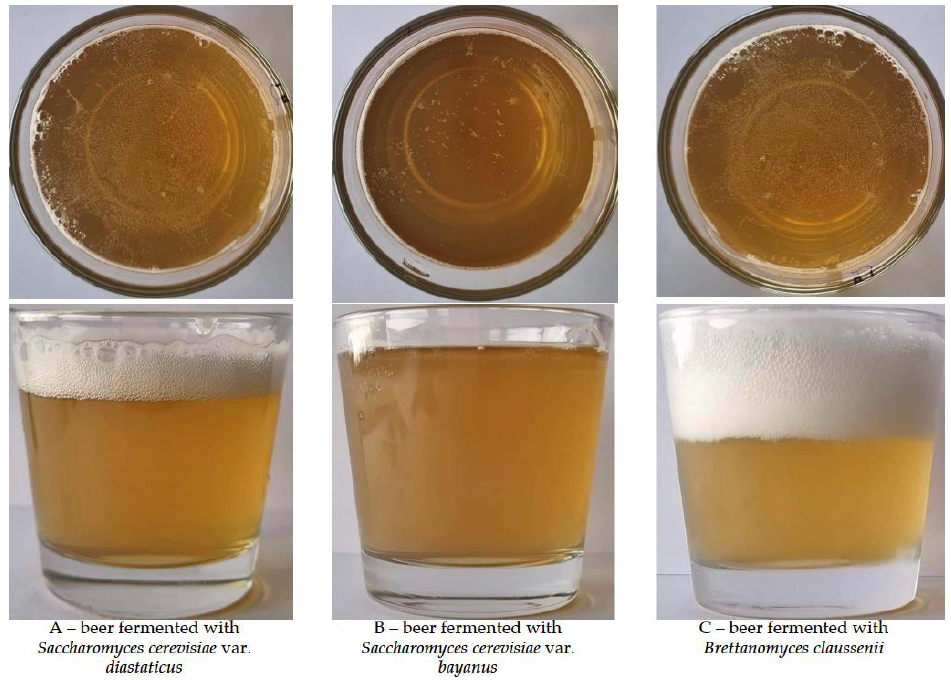
Figure 3. Pictures of the beer samples.